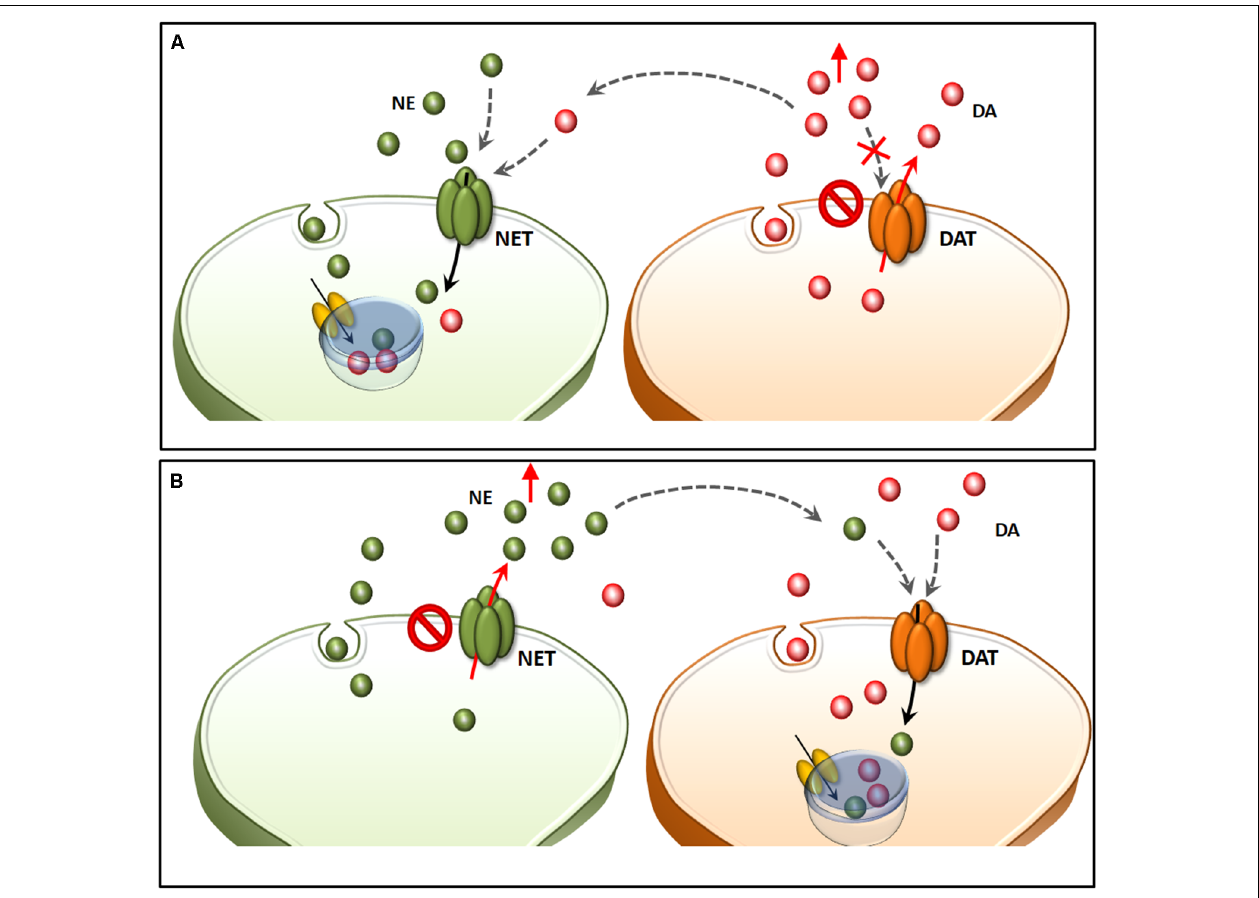
FIGURE 6 | Structural similarities between NET and DAT confound neuron-specific NE and DA compartmentalization. Both NET and DAT represent the evolutionary divergence of a single catecholamine transporter (meNET), which was isolated and characterized already in the brain of the teleost fish medaka (Roubert et al., 2001). In the light of a strong structural similarity, both NET and DAT take up extracellular DA with a similar potency (A) . In fact, in the presence of an excess of extracellular DA (due to either a selective blockade of DAT or a reverted direction of DA transport), this may compete effectively with NE, thus being